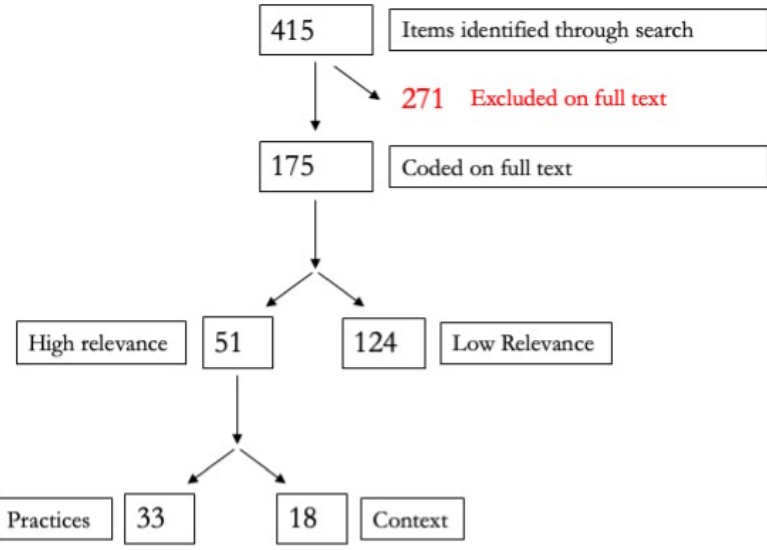
Figure 2. PRISMA flow chart for the grey literature.